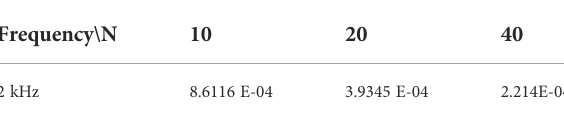
TABLE 1 Comparison of stealth effects of different layers. Frequency\N